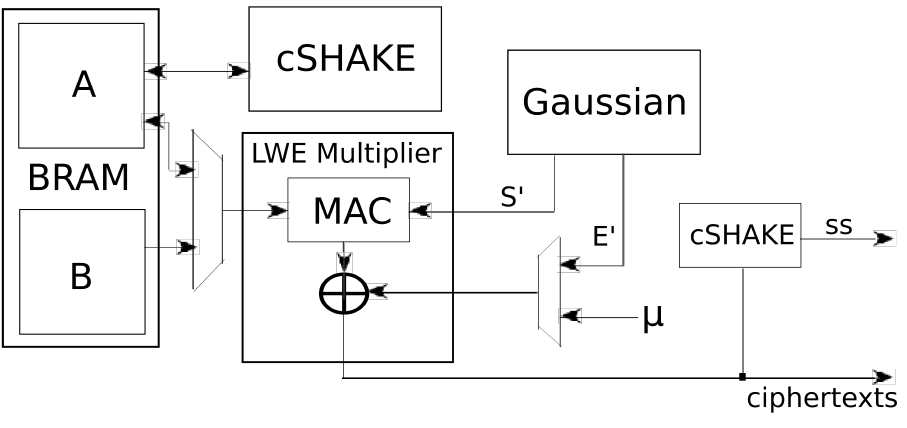
Figure 2: A high-level architecture of the FPGA design of FrodoKEM-cSHAKE